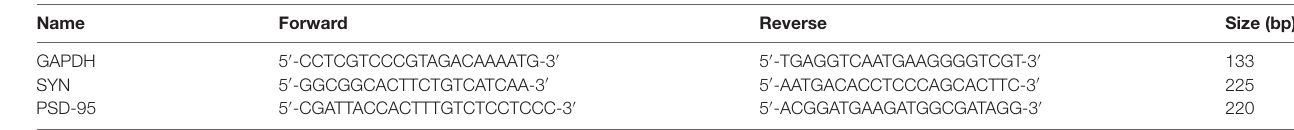
LC3-II ( F (1,30) = 414.1; p < 0.001) and Beclin-1 expression ( F (1,30) = 448.8; p < 0.001) on days 1, 3 and 7